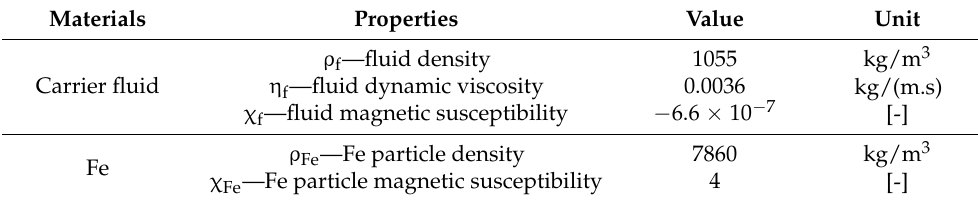
Table 7. Magnetic suspension component properties.